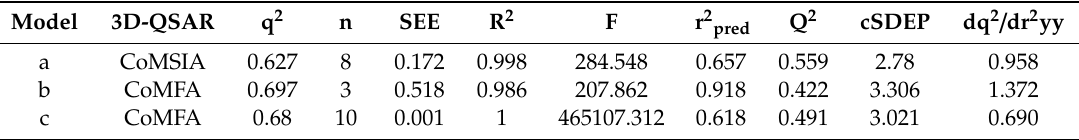
Table 4. Evaluation parameters of B. cepacia (a), A. fulgidus (b), P. aeruginosa (c). Biodegradation 3D-QSAR model of